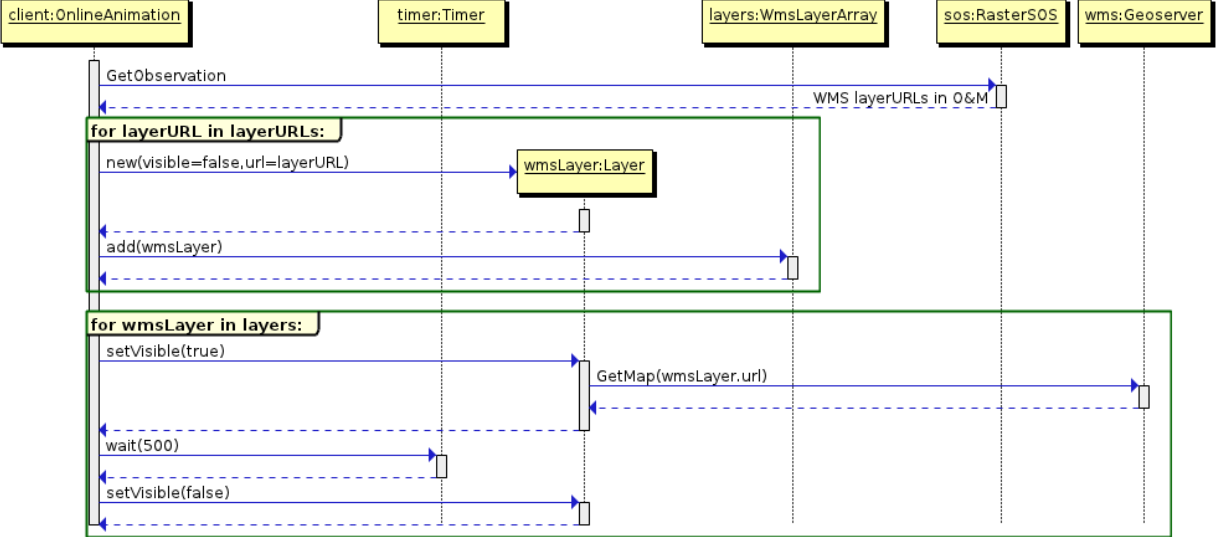
Figure 10. UML diagram of the communication between client, SOS, and